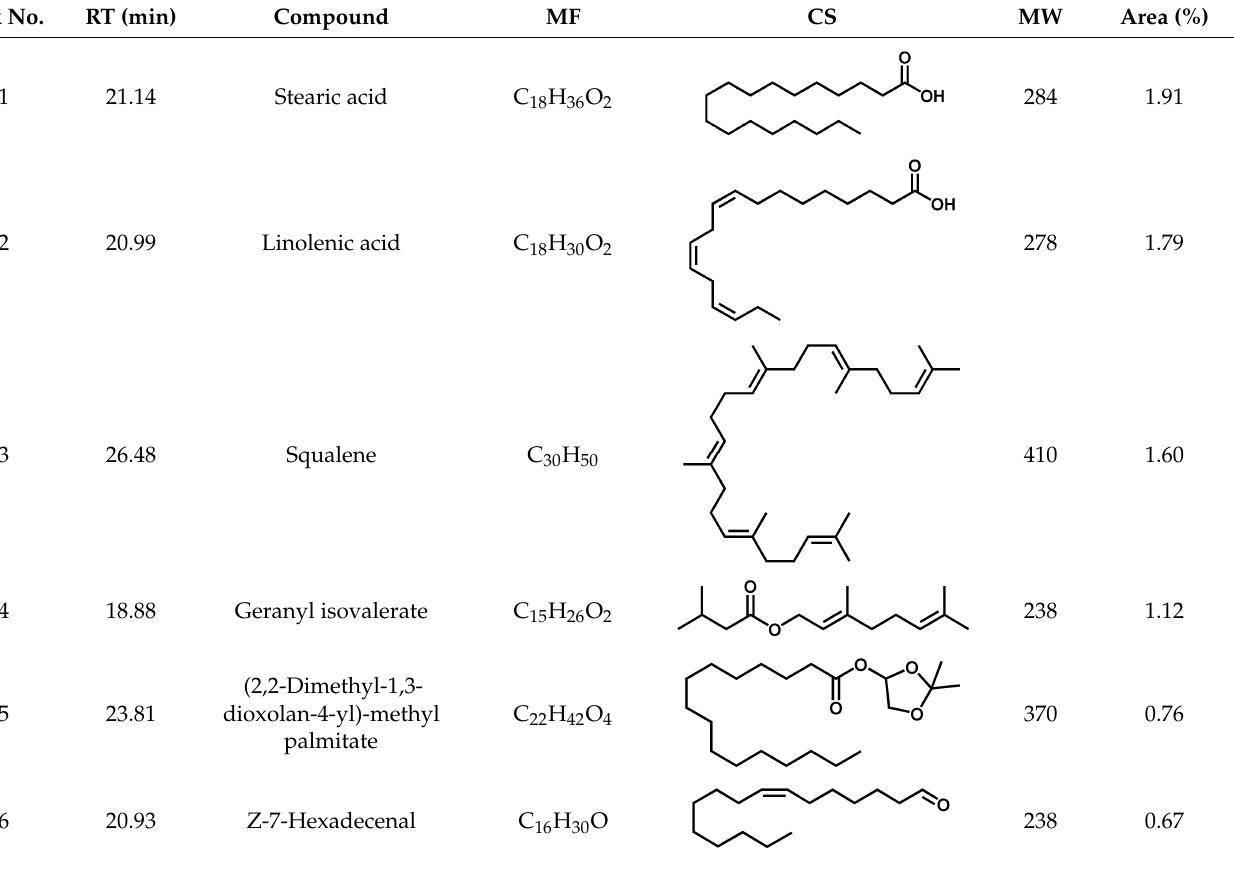
238 0.67 RT, retention time; MF, molecular formula; CS, chemical structure; MW, molecular weight. RT, retention time; MF, molecular formula; CS, chemical structure; MW, molecular weight. Z-7-Hexadecenal RT, retention time; MF, molecular formula; CS, chemical structure; MW, molecular weight. 2.5. Dose-Dependent Cytotoxic Effects of N. miranda-Leaf-Acetone on the Survival and Migration 2.5. Dose-Dependent Cytotoxic Effects of N. miranda-Leaf-Acetone on the Survival and of PC-9, 4T1, and B16F10 Cells RT, retention time; MF, molecular formula; CS, chemical structure; MW, molecular weight. Migration of PC-9, 4T1, and B16F10 Cells 2.5. Dose-Dependent Cytotoxic Effects of N. miranda-Leaf-Acetone on the Survival and PC-9 cells incubated with N. miranda -leaf-acetone of 200 µ g/mL were almost com- RT, retention time; MF, molecular formula; CS, chemical structure; MW, molecular weight. PC-9 cells incubated with N. miranda -leaf-acetone of 200 μ g/mL were almost com- Migration of PC-9, 4T1, and B16F10 Cells 2.5. Dose-Dependent Cytotoxic Effects of N. miranda-Leaf-Acetone on the Survival and pletely killed (Figure 2). Different concentrations of N. miranda -leaf-acetone (0, 40, 80, 100, pletely killed (Figure 2). Different concentrations of N. miranda -leaf-acetone (0, 40, 80, 100, RT, retention time; MF, molecular formula; CS, chemical structure; MW, molecular weight. PC-9 cells incubated with N. miranda -leaf-acetone of 200 μ g/mL were almost com- Migration of PC-9, 4T1, and B16F10 Cells and 150 µ g/mL) were used to demonstrate further the cytotoxic effects on the survival and 2.5. Dose-Dependent Cytotoxic Effects of N. miranda-Leaf-Acetone on the Survival and and 150 μ g/mL) were used to demonstrate further the cytotoxic effects on the survival and pletely killed (Figure 2). Different concentrations of N. miranda -leaf-acetone (0, 40, 80, 100, migration of PC-9 cells (Figure 4A). The cytotoxic effects of N. miranda -leaf-acetone against RT, retention time; MF, molecular formula; CS, chemical structure; MW, molecular weight. PC-9 cells incubated with N. miranda -leaf-acetone of 200 μ g/mL were almost com- Migration of PC-9, 4T1, and B16F10 Cells migration of PC-9 cells (Figure 4A). The cytotoxic effects of N. miranda -leaf-acetone against 2.5. Dose-Dependent Cytotoxic Effects of N. miranda-Leaf-Acetone on the Survival and and 150 μ g/mL) were used to demonstrate further the cytotoxic effects on the survival and 4T1 mammary carcinoma (Figure 4B) and B16F10 melanoma (Figure 4C) cells were also pletely killed (Figure 2). Different concentrations of N. miranda -leaf-acetone (0, 40, 80, 100, 4T1 mammary carcinoma (Figure 4B) and B16F10 melanoma (Figure 4C) cells were also PC-9 cells incubated with N. miranda -leaf-acetone of 200 μ g/mL were almost com- Migration of PC-9, 4T1, and B16F10 Cells migration of PC-9 cells (Figure 4A). The cytotoxic effects of N. miranda -leaf-acetone against 2.5. Dose-Dependent Cytotoxic Effects of N. miranda-Leaf-Acetone on the Survival and investigated and compared. Incubation with N. miranda -leaf-acetone of 0, 40, 80, 100, and and 150 μ g/mL) were used to demonstrate further the cytotoxic effects on the survival and investigated and compared. Incubation with N. miranda -leaf-acetone of 0, 40, 80, 100, and pletely killed (Figure 2). Different concentrations of N. miranda -leaf-acetone (0, 40, 80, 100, 4T1 mammary carcinoma (Figure 4B) and B16F10 melanoma (Figure 4C) cells were also PC-9 cells incubated with N. miranda -leaf-acetone of 200 μ g/mL were almost com- 150 µ g/mL caused the deaths of PC-9 cells at the rate of 0, 1, 11, 62, and 98%, respectively. Migration of PC-9, 4T1, and B16F10 Cells migration of PC-9 cells (Figure 4A). The cytotoxic effects of N. miranda -leaf-acetone against 150 μ g/mL caused the deaths of PC-9 cells at the rate of 0, 1, 11, 62, and 98%, respectively. and 150 μ g/mL) were used to demonstrate further the cytotoxic effects on the survival and investigated and compared. Incubation with N. miranda -leaf-acetone of 0, 40, 80, 100, and pletely killed (Figure 2). Different concentrations of N. miranda -leaf-acetone (0, 40, 80, 100, The same concentrations of N. miranda -leaf-acetone used against 4T1 and B16F10 cells were PC-9 cells incubated with N. miranda -leaf-acetone of 200 μ g/mL were almost com- 4T1 mammary carcinoma (Figure 4B) and B16F10 melanoma (Figure 4C) cells were also The same concentrations of N. miranda -leaf-acetone used against 4T1 and B16F10 cells migration of PC-9 cells (Figure 4A). The cytotoxic effects of N. miranda -leaf-acetone against much more efficient than against PC-9 cells. For example, incubation with N. miranda -leaf- 150 μ g/mL caused the deaths of PC-9 cells at the rate of 0, 1, 11, 62, and 98%, respectively. and 150 μ g/mL) were used to demonstrate further the cytotoxic effects on the survival and pletely killed (Figure 2). Different concentrations of N. miranda -leaf-acetone (0, 40, 80, 100, investigated and compared. Incubation with N. miranda -leaf-acetone of 0, 40, 80, 100, and 4T1 mammary carcinoma (Figure 4B) and B16F10 melanoma (Figure 4C) cells were also acetone of 80 µ g/mL caused the deaths of 4T1 and B16F10 cells at the rates of 60 and 71%, The same concentrations of N. miranda -leaf-acetone used against 4T1 and B16F10 cells migration of PC-9 cells (Figure 4A). The cytotoxic effects of N. miranda -leaf-acetone against and 150 μ g/mL) were used to demonstrate further the cytotoxic effects on the survival and 150 μ g/mL caused the deaths of PC-9 cells at the rate of 0, 1, 11, 62, and 98%, respectively. investigated and compared. Incubation with N. miranda -leaf-acetone of 0, 40, 80, 100, and while only 11% of PC-9 cells were affected. Accordingly, N. miranda -leaf-acetone was also 4T1 mammary carcinoma (Figure 4B) and B16F10 melanoma (Figure 4C) cells were also migration of PC-9 cells (Figure 4A). The cytotoxic effects of N. miranda -leaf-acetone against The same concentrations of N. miranda -leaf-acetone used against 4T1 and B16F10 cells 150 μ g/mL caused the deaths of PC-9 cells at the rate of 0, 1, 11, 62, and 98%, respectively. useful against 4T1 and B16F10 cells, and the cytotoxic activities of N. miranda -leaf-acetone investigated and compared. Incubation with N. miranda -leaf-acetone of 0, 40, 80, 100, and 4T1 mammary carcinoma (Figure 4B) and B16F10 melanoma (Figure 4C) cells were also The same concentrations of N. miranda -leaf-acetone used against 4T1 and B16F10 cells followed the order: B16F10 > 4T1 > PC-9 150 μ g/mL caused the deaths of PC-9 cells at the rate of 0, 1, 11, 62, and 98%, respectively. investigated and compared. Incubation with N. miranda -leaf-acetone of 0, 40, 80, 100, and The same concentrations of N. miranda -leaf-acetone used against 4T1 and B16F10 cells 150 μ g/mL caused the deaths of PC-9 cells at the rate of 0, 1, 11, 62, and 98%, respectively. The same concentrations of N. miranda -leaf-acetone used against 4T1 and B16F10 cells